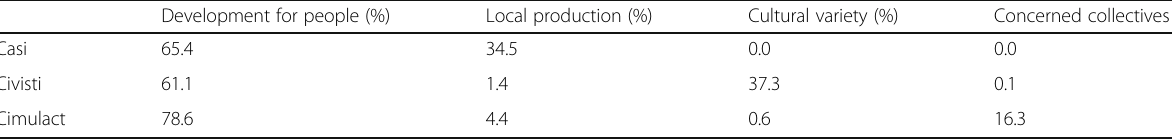
Table 3 Distribution of topics across the examined citizen involvement projects Development for people